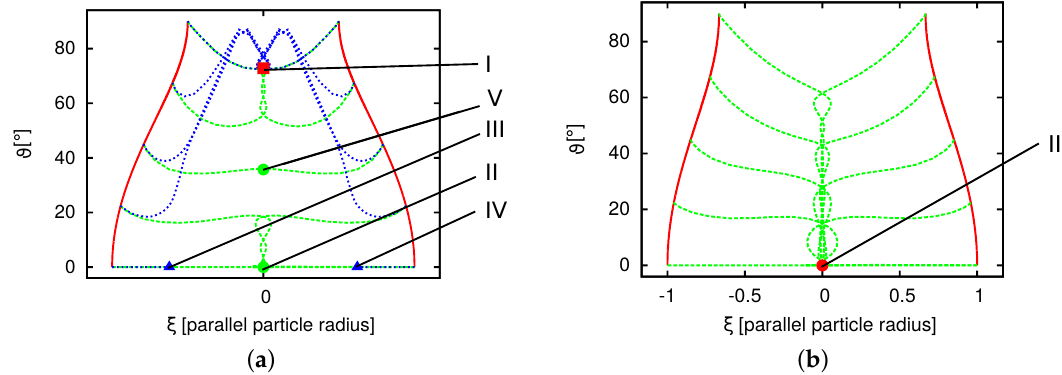
Figure 8. ϑ (cid:48) - ξ -plots for the adsorption of a single Janus with different values of m and ∆ θ . Line and end point colors are identical to Figure 7a. The Roman numerals relate the points for the final states in Figure 7b. State “V” is a tilted state similar to state “I”, but with a different angle ϑ . ( a ) ( ∆ θ ≈ 19.5 ◦ , m = 2) The structure of the ϑ - ξ plot is more complicated as compared to Figure 7a. For the PIO, there are two different tilted states. Furthermore, the range of initial orientations for the final upright orientation is extended. ( b ) ( m = 1.5 and ∆ θ ≈ 19.5 ◦ ) Only one final point exists for the upright position ϑ final = ϑ upright = 0 as shown by the left particle in Figure